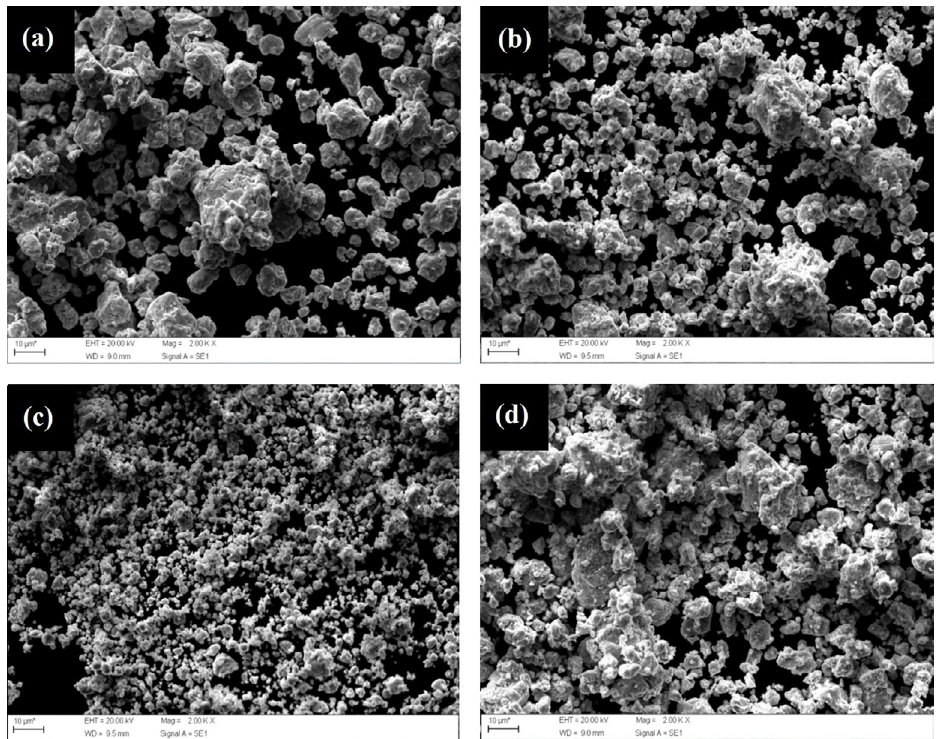
Figure 3. SEM of the AISI 52100 steel milled through 20 hours with (a) 0% of alumina (b) 1% of alumina (c) 3% of alumina (d) 5% of